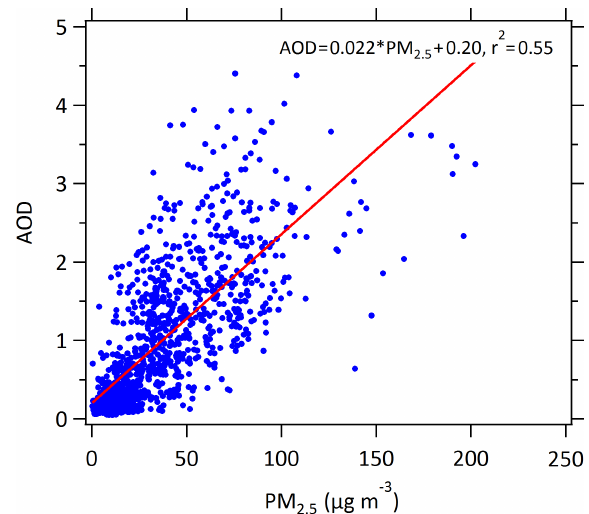
Figure 7. Correlation between AOD and PM 2 . 5 in Beijing in sum- mertime during 2009–2016.